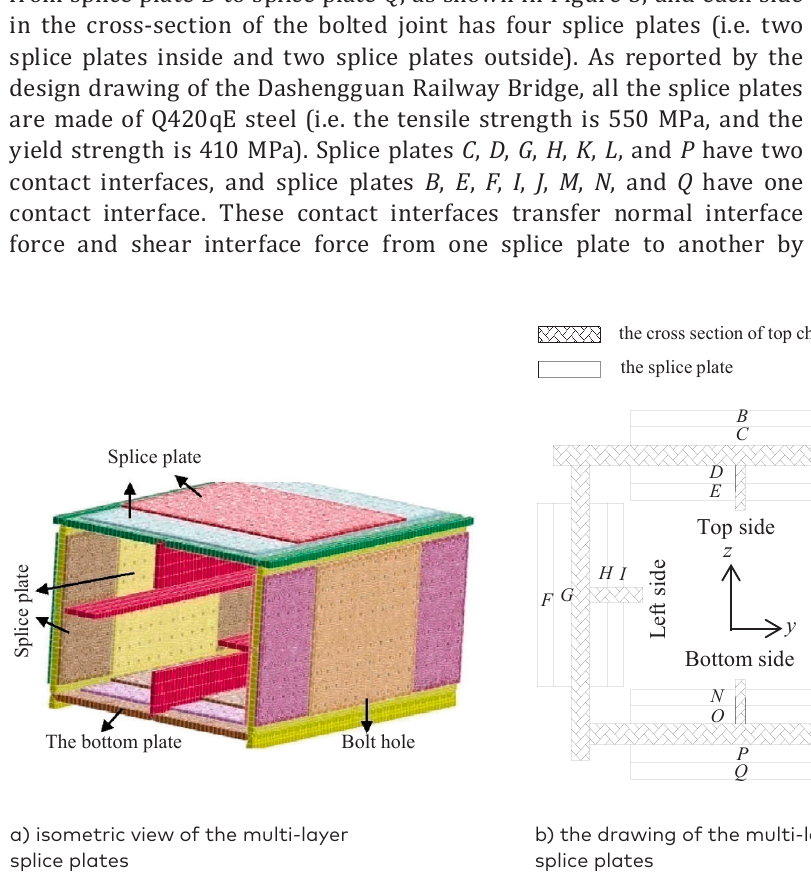
Figure 5. The details of multi-layer